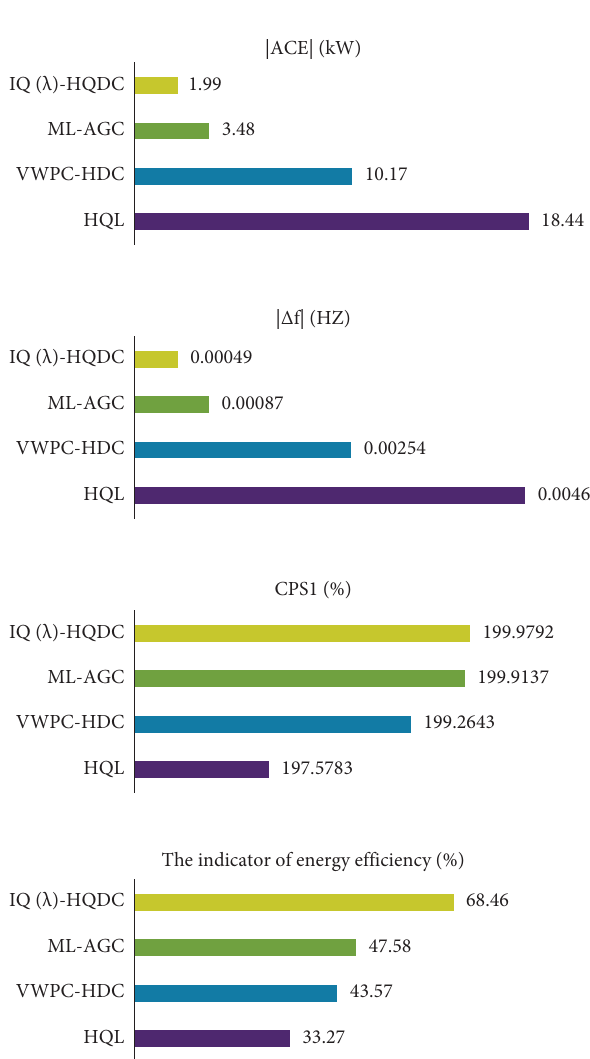
Figure 8: Te control performance of four strategies under white noise